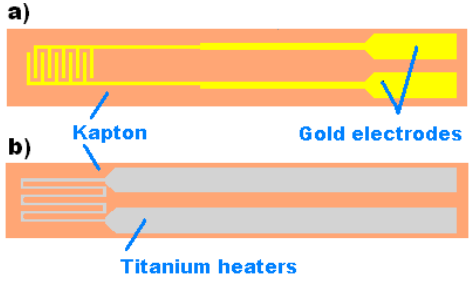
Figure 1. Schematic diagram of the flexible sensor ( a ) Top part of the sensor consisting of gold interdigitated electrodes; ( b ) Titanium heater deposited at the bottom part of the Kapton substrate.